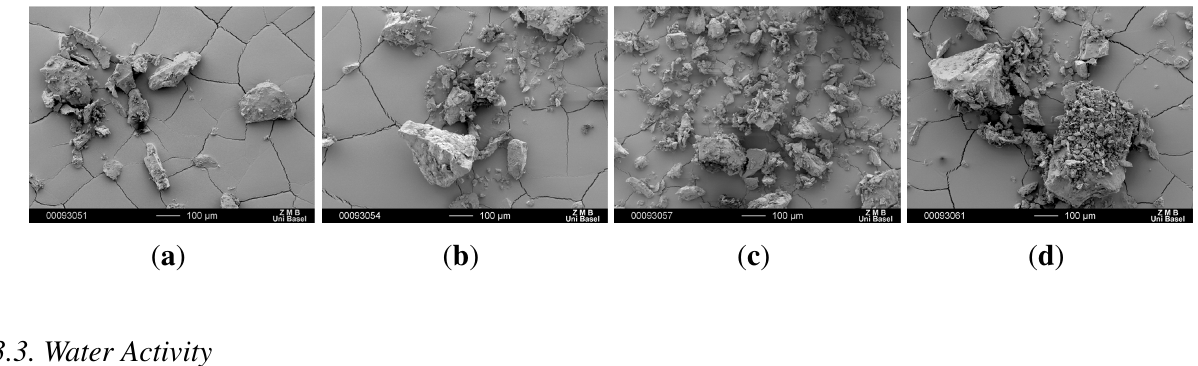
Figure 5. SEM pictures of recrystallized CBZ samples. ( a ) CBZ A re; ( b ) CBZ B